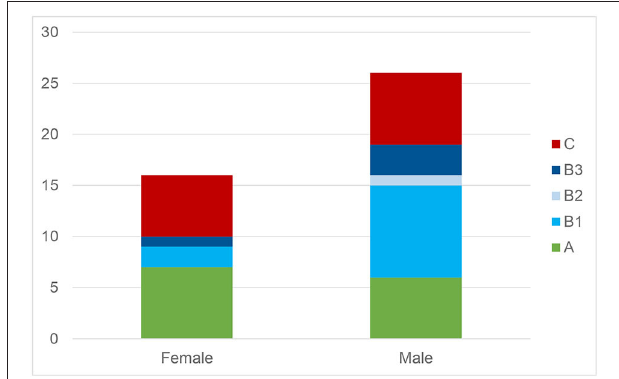
FIGURE 3 | Frequency of prosocial behavior in relation the children’s